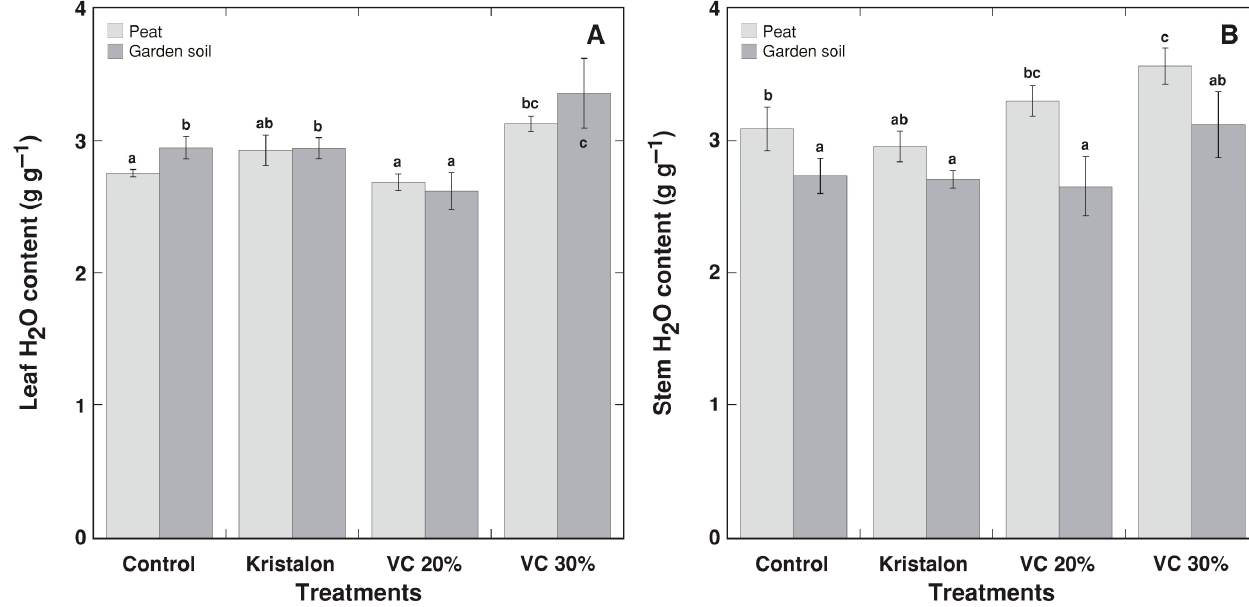
Figure 6. Effect of mineral fertilizer (Kristalon) and amendment with vermicompost (VC) at a 20% and 30% ( v / v ) rate on H 2 O content in leaves ( A ) and stems with inflorescences ( B ) of Dracocephalum moldavica plants grown in peat substrate or commercial garden soil for 8 weeks. Results are means ± SE from five replicates for each treatment. Means with identical letters are not considered statistically significantly different ( p < 0.05).